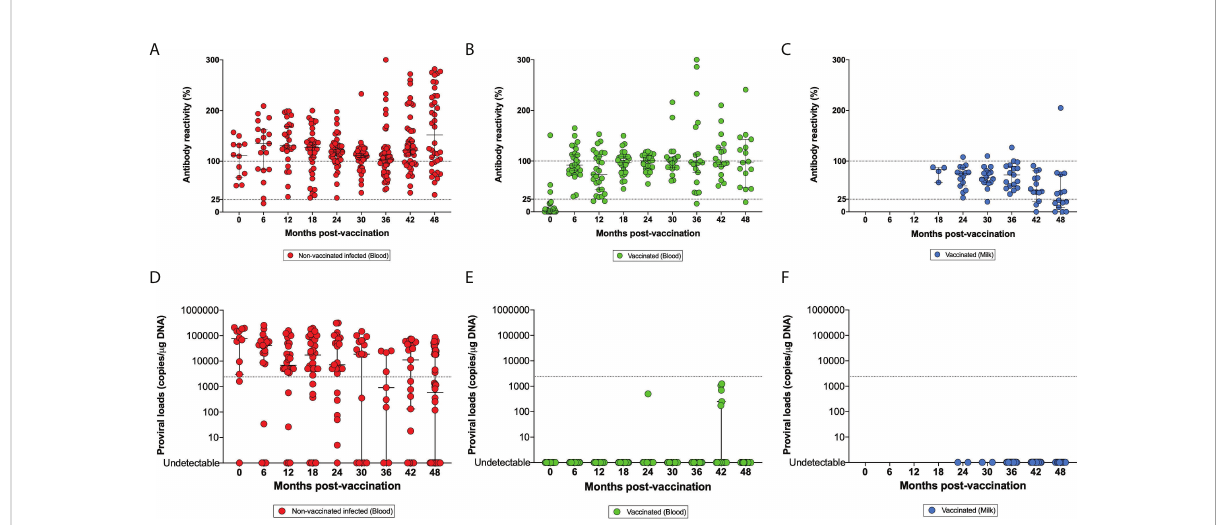
FIGURE 2 Kinetics of the antibody reactivities (A – C) and proviral loads (D – F) . Panels (A, D) correspond to blood samples of non-vaccinated animals infected with BLV (red). Blood samples ( B, E in green) and milk ( C, F in blue) have been collected from vaccinated animals. The dotted lines of panels (A – C) indicate the arbitrary cut-off point between high-low (100%) and low-negative (25%) antibody reactivities. In panels (D – F) , the dotted line is the threshold separating high and low proviral loads and corresponding to 1% of infected cells or 2,400 proviral copies/µg